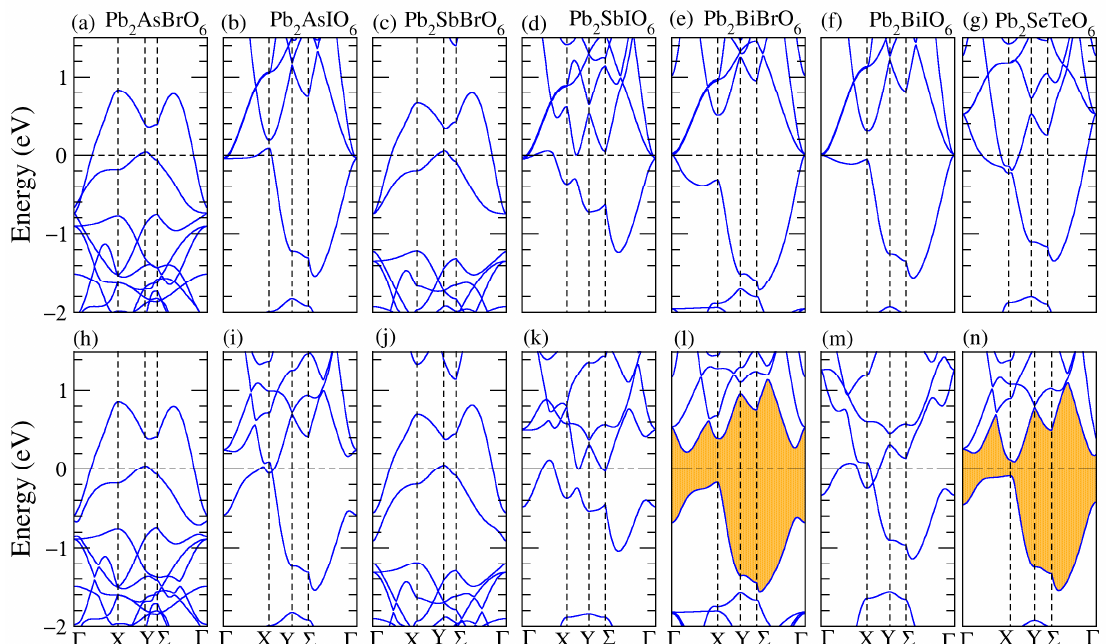
Figure 2. Scalar relativistic, upper panel ( a − g ), and fully relativistic, bottom panel ( h − n ), electronic band structures of the Pb 2 AA’O 6 (A = Sb and Bi; A’ = Br and I) and Pb 2 SeTeO 6 double perovskites. The Fermi energy is set to be zero. The orange colors in ( l , n ) represents the bandgaps.